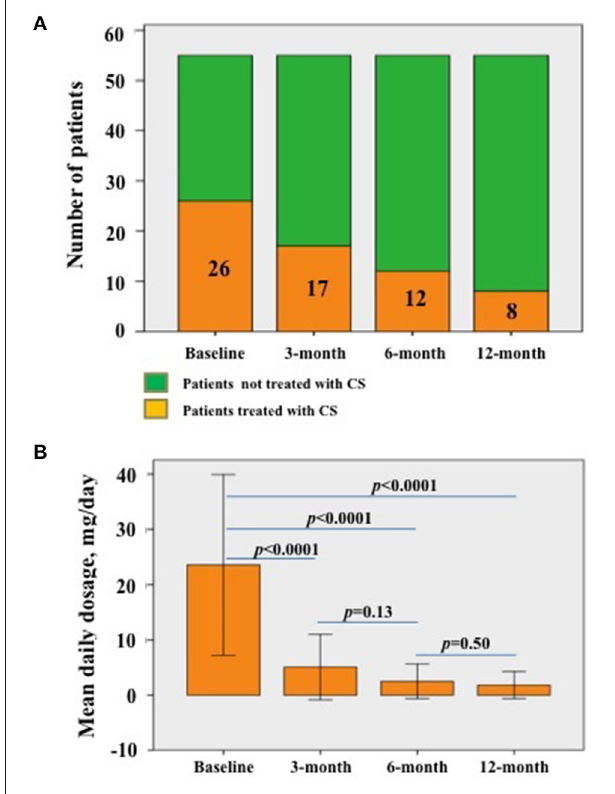
FIGURE 5 | Details about corticosteroid administration. (A) Patients taking corticosteroids at the start of biologic treatments (baseline) and at the following visits; the decrease is statistically significant ( p = 0.025). The numbers contained in the histograms refer to the specific number of patients taking corticosteroids at the corresponding visit. (B) Median daily corticosteroid dosage (as prednisone or equivalent) among patients already treated with corticosteroids at the different follow-up visits; the decrease is statistically significant ( p < 0.0001). Statistical differences regarding the daily corticosteroid dosage between different follow-up visits have also been provided in the figure.; error bars in (B) refer to one standard